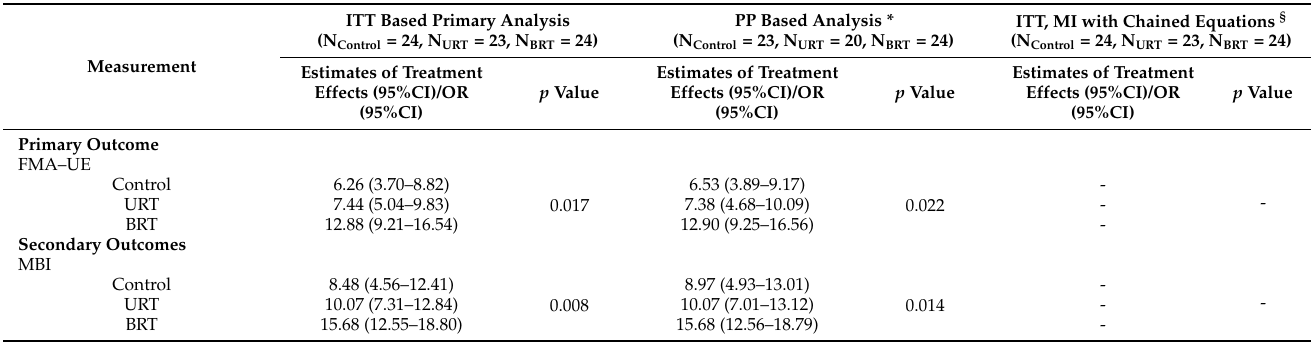
Table 3. Results of sensitivity